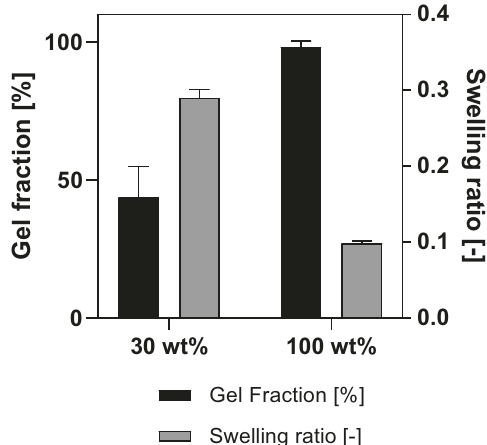
Fig. 3 Measured swelling ratio and gel fraction of AUP530 at two different concentrations (i.e. 30 and 100